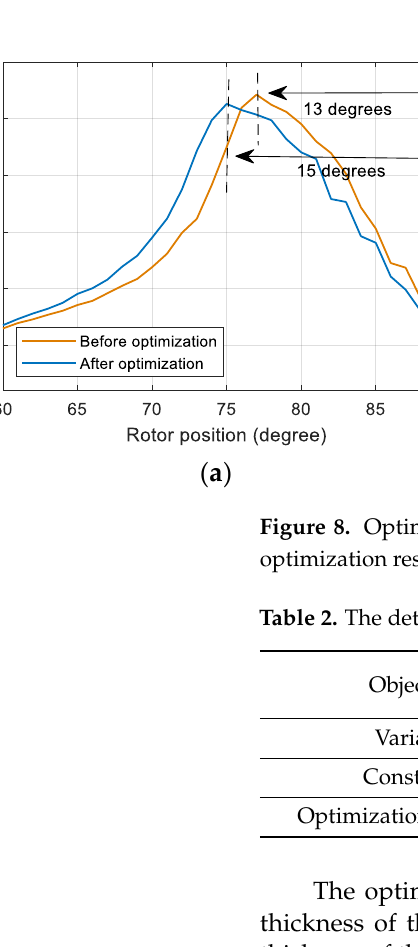
( b ) Figure 7. FEM simulation results of the proposed SRM: ( a ) the mesh distribution; ( b ) the magnitude of the magnetic flux density. Table 2 lists the details of the optimization method. The objective is to minimize the distance between the maximum torque point and the 75-degree position. When the max- imum torque point is fixed to the 75-degree position, the distance between the maximum torque point and the zero-torque point will be 15 degrees. The torque waveforms of the next phase are shifted by 15 degrees. As a result, the maximum torque point of the present